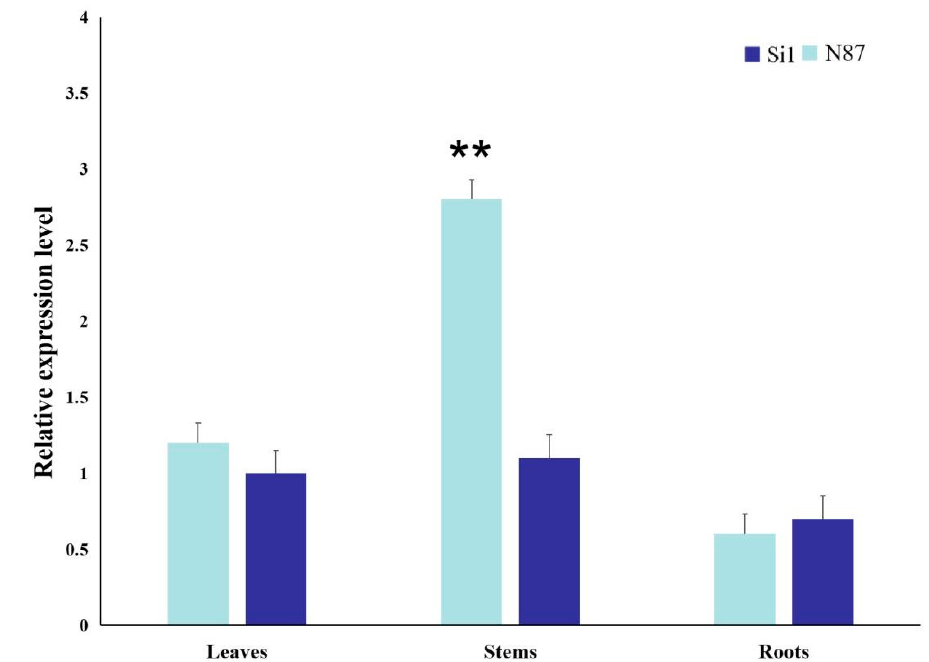
Figure 6. Relative expression level of CmaSI1 in different tissues of Si1 and WT N87. Error bars indicate standard deviations from three repeats ( n = 3). Values are means + SD ( n = 3). ** Significant at p < 0.01.